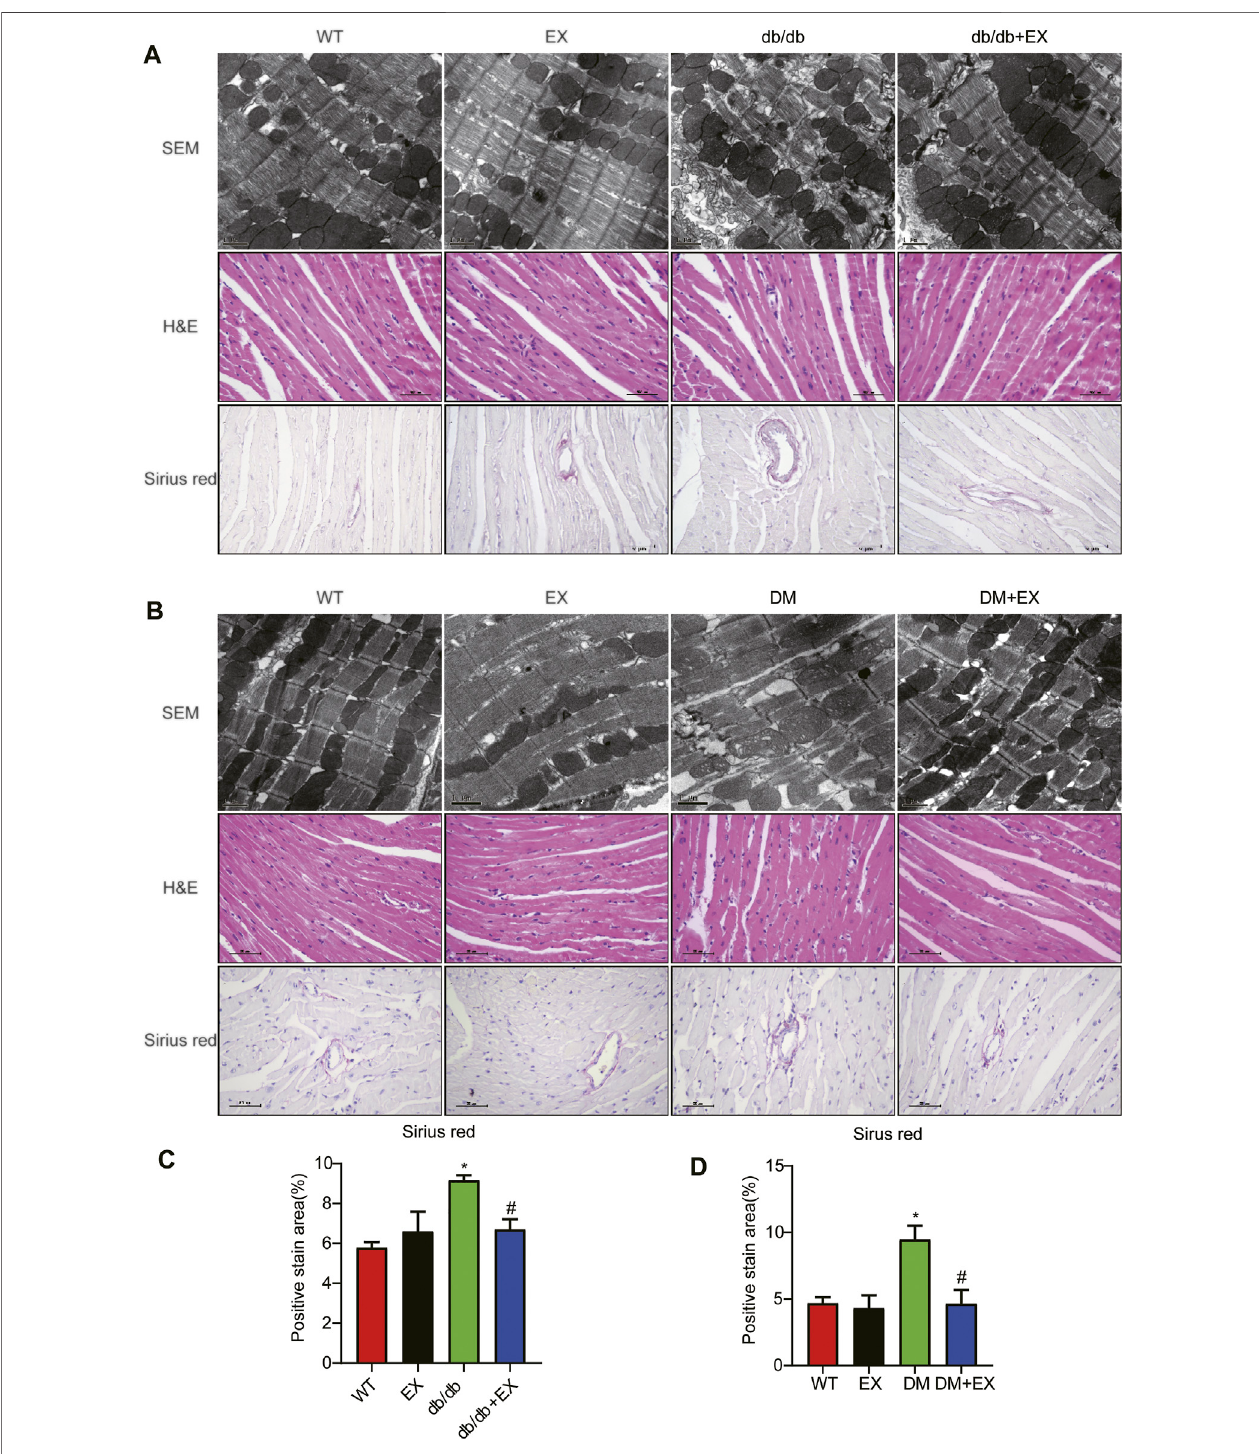
FIGURE 6 | Exercise mitigated myocardial remodeling in diabetic mice. (A,B) SEM images of mouse myocardial tissue, hematoxylin – eosin (H&E) and Sirius red quantitative statistical images of Sirius red detecting myocardial fi brosis (C,D) . * p < 0.05 vs. the WT group, # p < 0.05 vs. the db/db group.